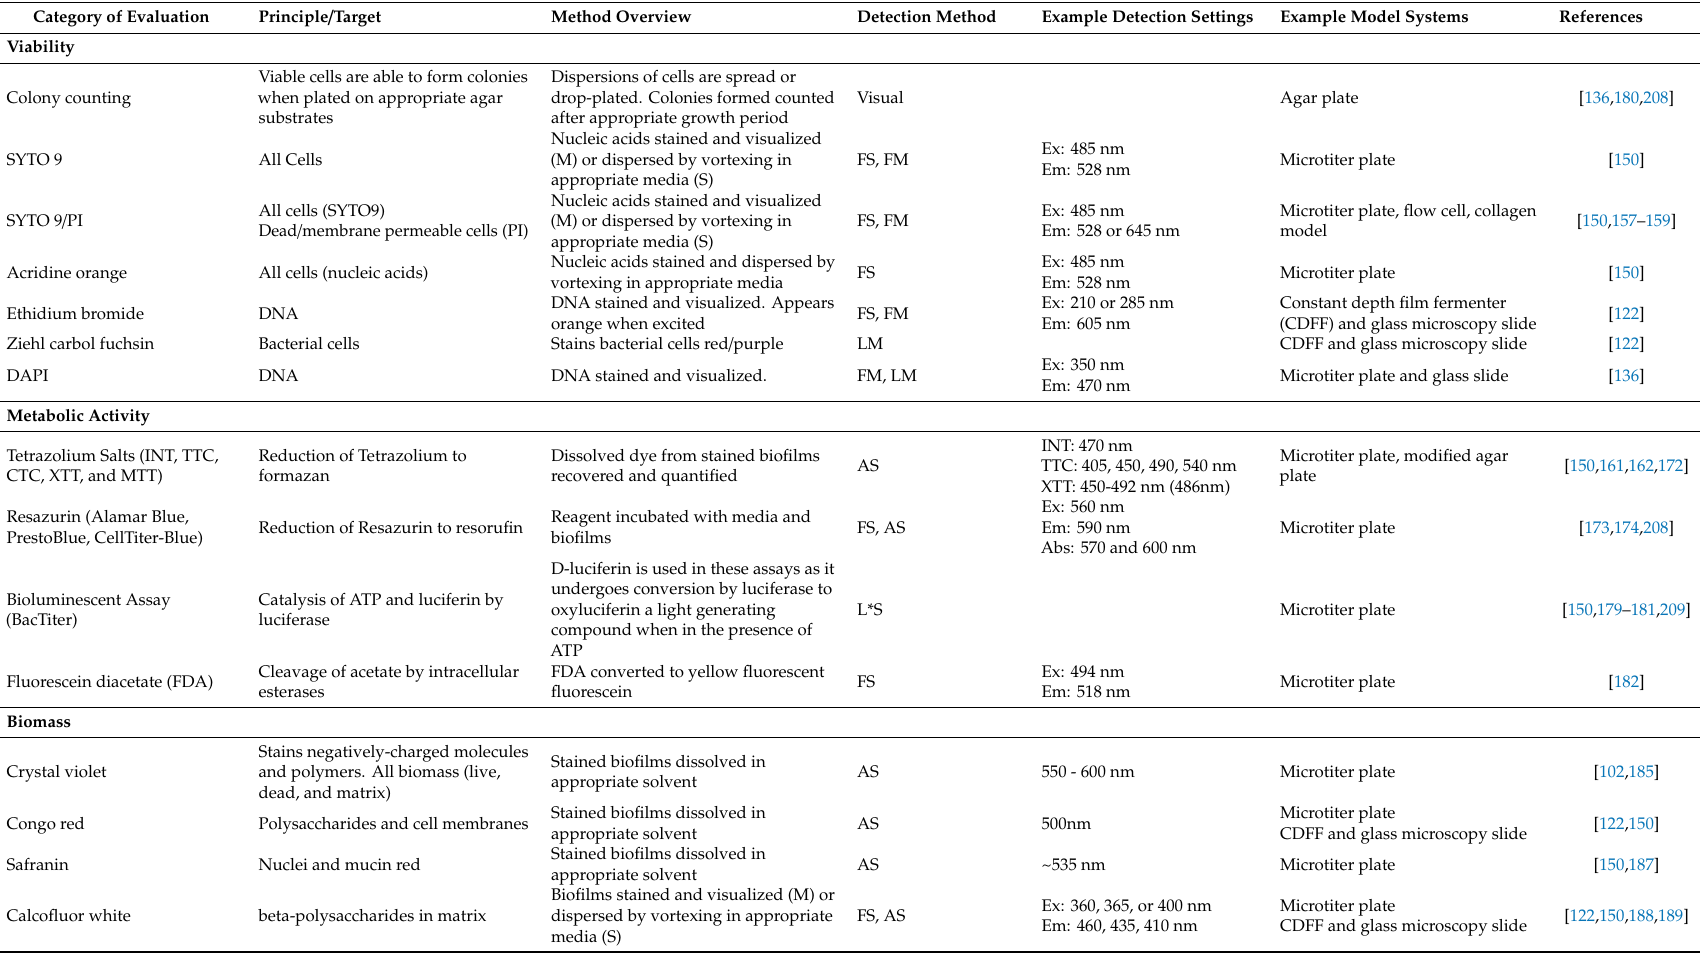
Table 2. Methods for Biofilm Analysis used with P. aeruginosa and S. aureus biofilms in